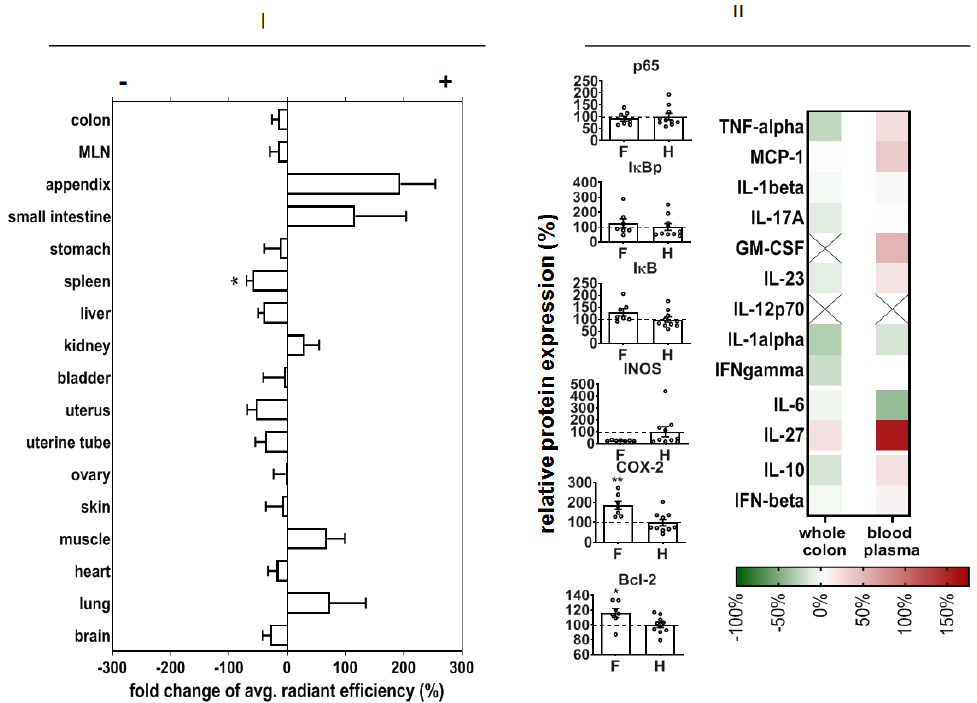
Figure 7. Off-target effects of p65 functional NPs after intravenous injection. ( I ) Changed accumulation of nanoparticles in colitis-bearing animals relative to healthy ones (fold changed NP accumulation, left). Nanoparticles were injected intravenously (2.0 mg siRNA/kg body weight in NaCl) at experimental day 3 in mice with DSS-induced colitis or in healthy mice. F—NPs in animals with colitis, H—healthy animals (with NPs). Mean ± SEM). ( II ) Impact on protein expression in the whole colon (left) and cytokine expression in colon tissue and blood plasma (right) on recovery day 4. Cytokine expression was related to the expression levels in non-treated healthy animals (in %, no NPs); X—cytokine level below the detection threshold. Mean ± SEM; n = 6 to 10. Significant difference compared to group H with p < 0.05 (*) and p < 0.01 (**).